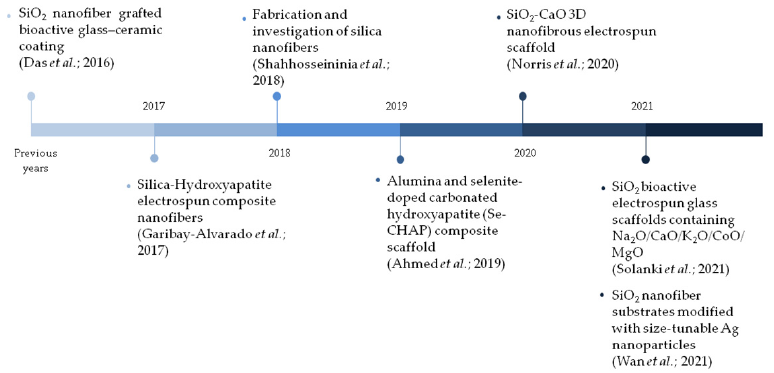
Figure 2. Main studies addressing ceramic nanofibers applied in wound-healing applications over the last six years the last six years [20,66–71].